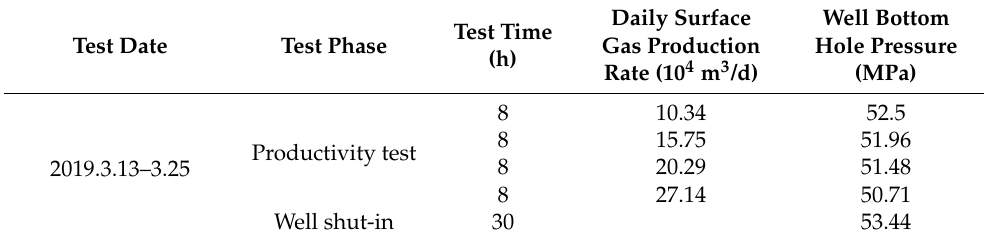
Table 2. Pir-21 well test data.